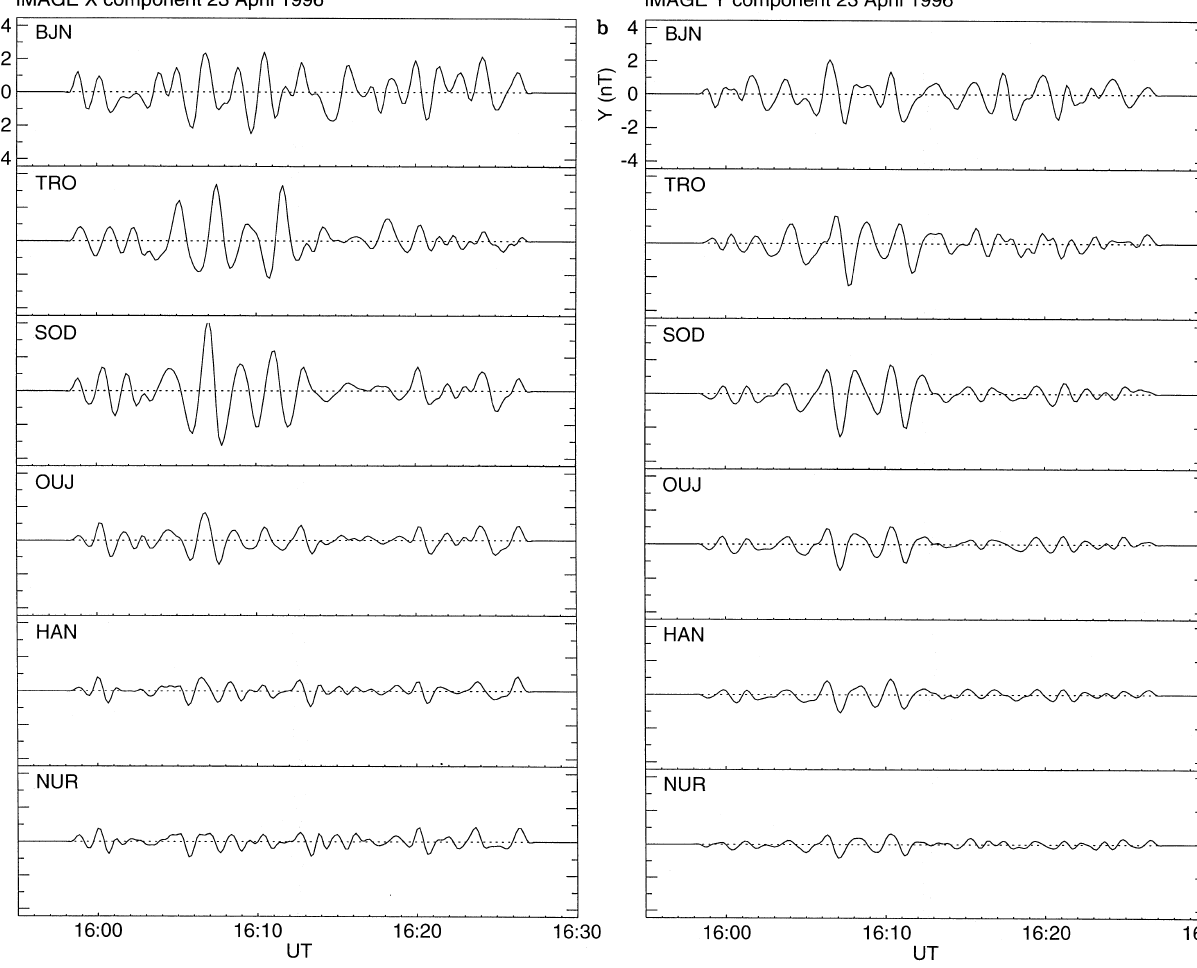
Fig. 3 a,b. Magnetic field data from six IMAGE magnetometer stations, bandpass filtered between 150 and 50 s (6.67–20.0 mHz), for a the X component and b the